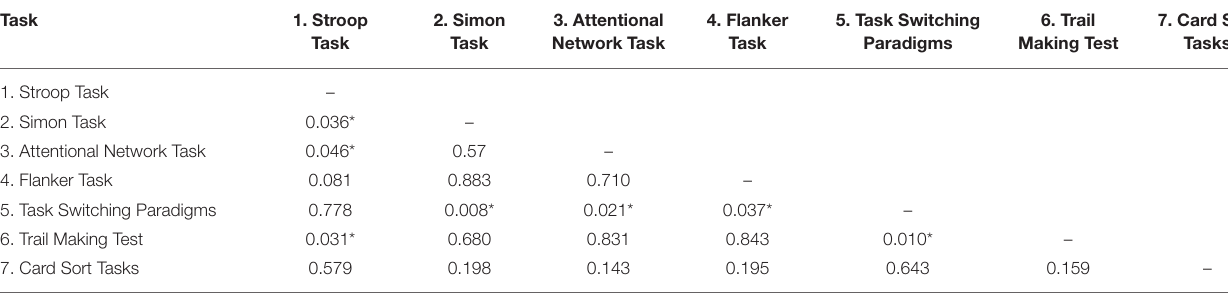
TABLE 2 | p -values from subgroup analyses comparing pairs of reaction time effect sizes from congruent trials. Task